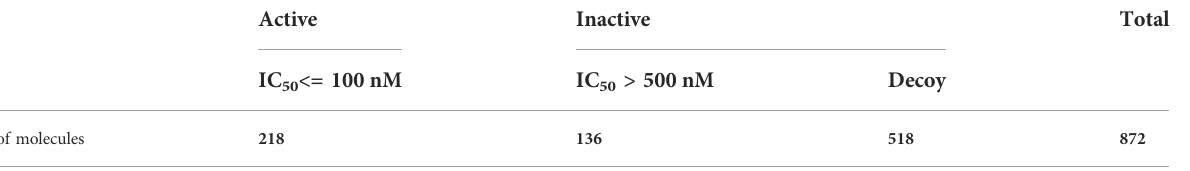
TABLE 1 Training and test dataset used in our study.